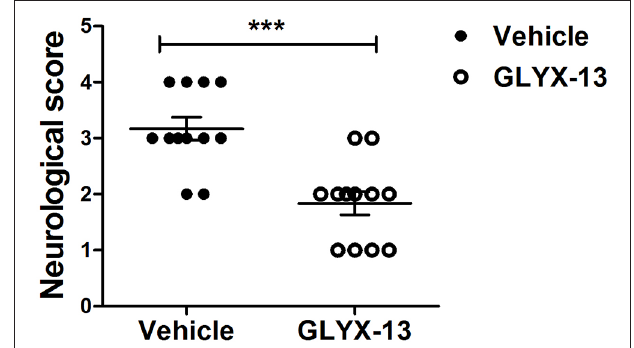
FIGURE 1 | Effect of GLYX-13 on Neurological function. Neurological score were evaluated 24 h after reperfusion. Statistical analysis was determined by Mann-Whitney U -test, n = 12, ∗∗∗ p < 0.001.